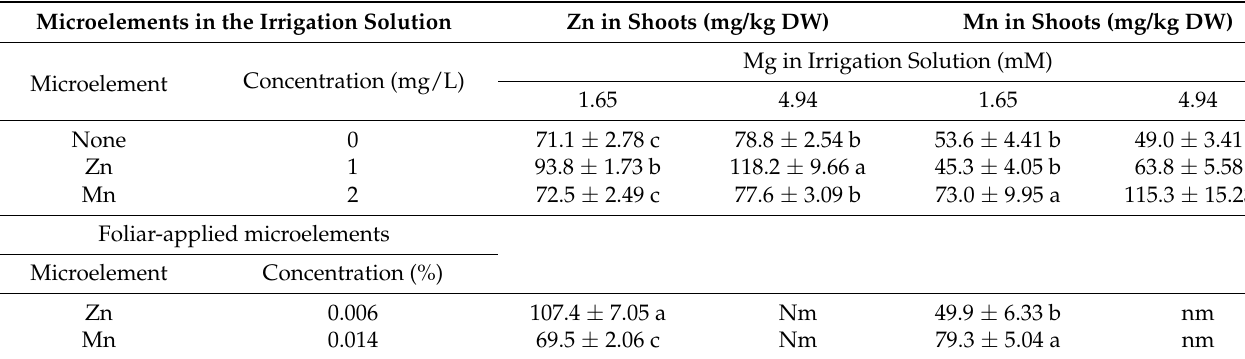
Values for each Mg treatment and each microelement treatment that are followed by a different letter are significantly different according to one-way ANOVA with Tukey’s HSD test. The default significance level was set at p ≤ 0.05. nm—not measured. DW—dry